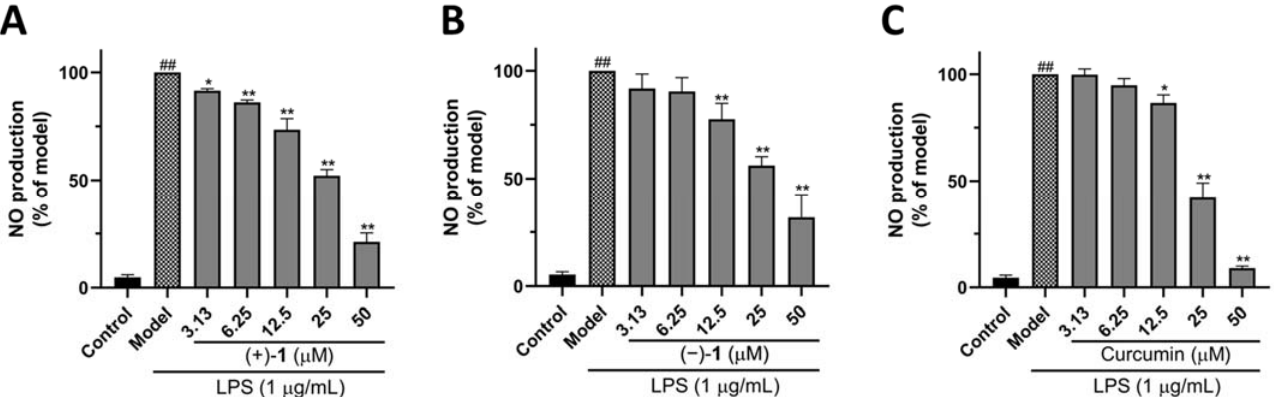
Figure 5. The inhibitory effect of compounds (+) ‐ 1 and ( − ) ‐ 1 against LPS ‐ induced NO production on RAW 264.7 cells. ( A ) Compound (+) ‐ 1 reduced the production of NO. ( B ) Compound ( − ) ‐ 1 reduced the production of NO. ( C ) Curcumin reduced the production of NO. Values are presented as mean ± SEM of three independent experiments. ## p < 0.01 vs. control group, * p < 0.05, ** p < 0.01 vs. model group.